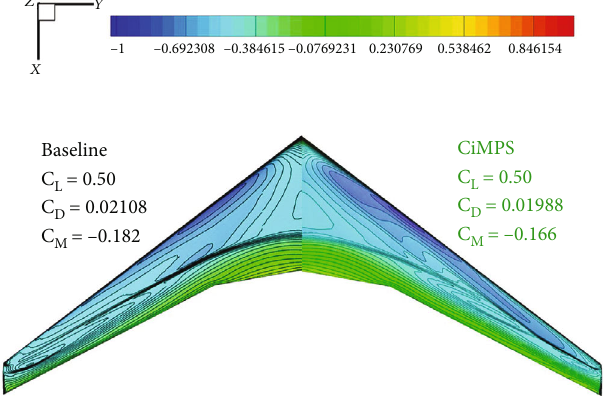
Figure 26: Pressure distributions of baseline and the CiMPS.